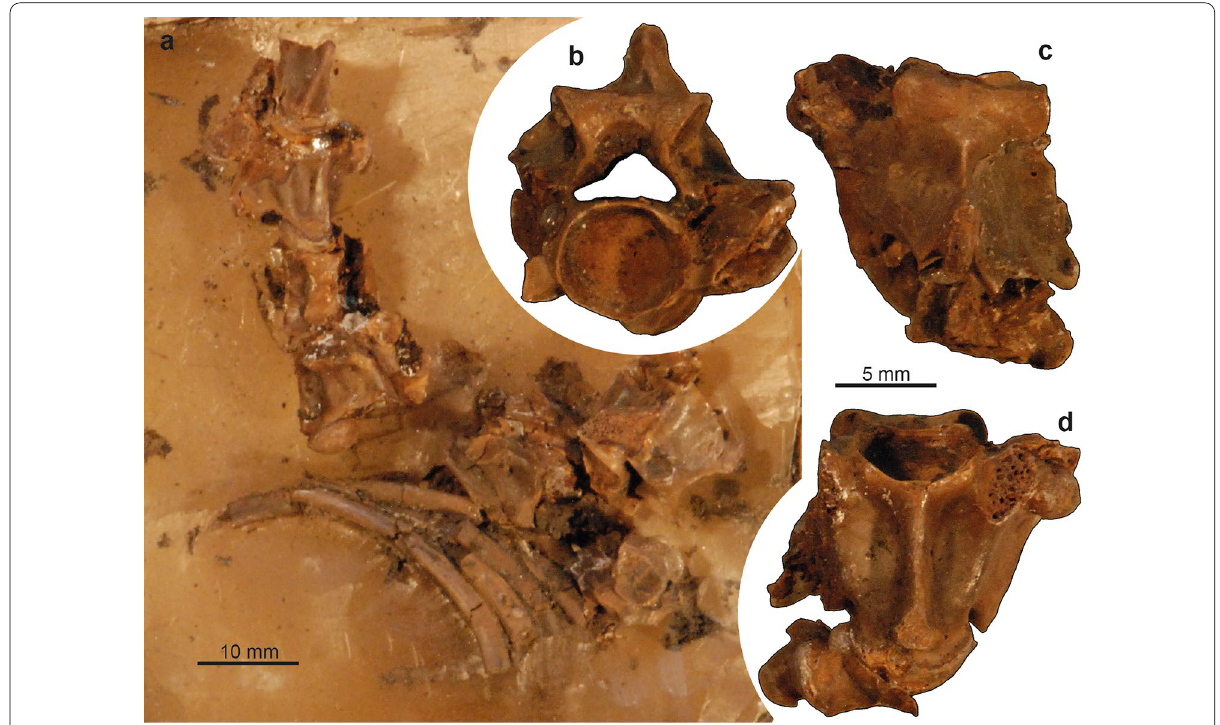
Fig. 66 Eoconstrictor cf. fischeri from quarry Cecilie I, Geiseltal: a small matrix with several articulated trunk vertebrae and remains of ribs (GMH Ce I-5852-1931); b – d close up of a posterior trunk vertebra from the same specimen in anterior ( b ), dorsal ( c ), and ventral ( d ) views